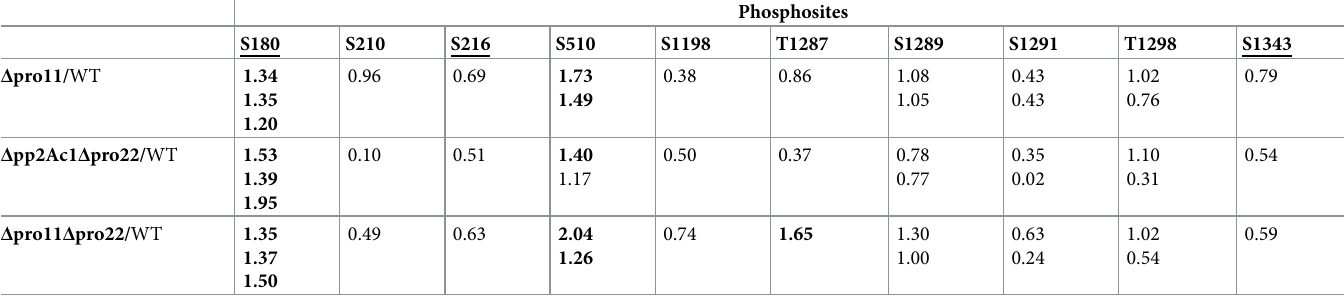
Table 2. Identified phosphorylation sites of GUL1. The phosphoproteomic study of Δ pro11, Δ pp2Ac1 Δ pro22, and Δ pro11 Δ pro22 compared to the wild type identified ten phosphorylation sites in GUL1. Two out of ten phosphorylation sites are differentially phosphorylated in all three STRIPAK mutants. For each phosphorylation site of GUL1, log2 ratio of reporter ion intensity in deletion strain and wild type relative to the respective standard deviation is given. Bold numbers indicate an upregulation of the phosphorylation site compared to the wild type. Regular numbers indicate no regulation of the phosphorylation site compared to the wild type. The underlined phos- phorylation sites were further analysed in this study (see also Fig 2). Standard deviations: Δ pro11: 0.62; Δ pp2Ac1 Δ pro22: 0.67; Δ pro11 Δ pro22: 0.57. In our previous study, we found seven phosphorylation sites (S1